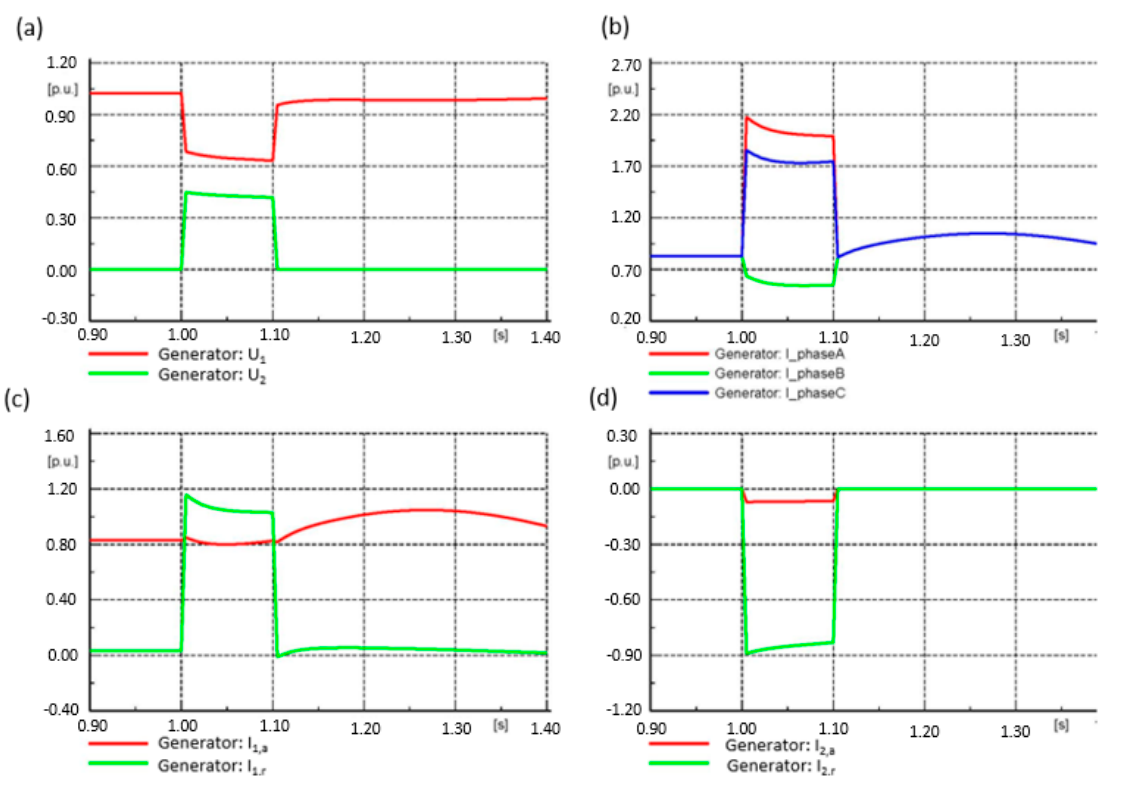
Figure 4. Contribution of a synchronous generator to a two-phase AB fault: ( a ) positive ( U 1 ) and negative ( U 2 ) sequence voltage; ( b ) phase current injection; ( c ) active ( I 1, a ) and reactive ( I 1, r ) current in positive sequence; ( d ) active ( I 2, a ) and reactive ( I 2, r ) current in negative sequence.